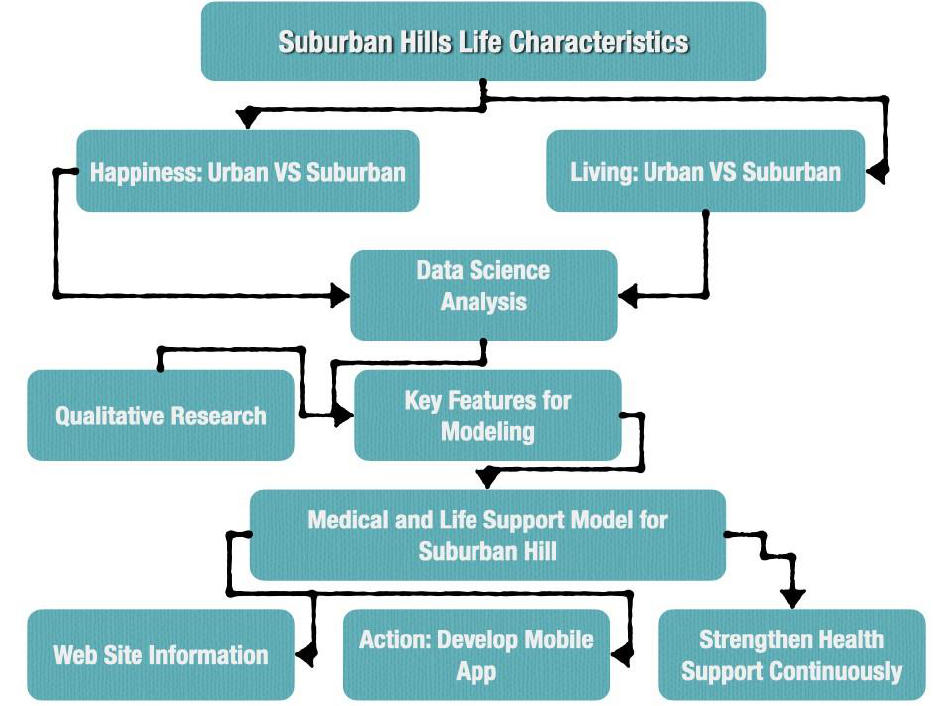
Figure 1. Data collection and analysis process.